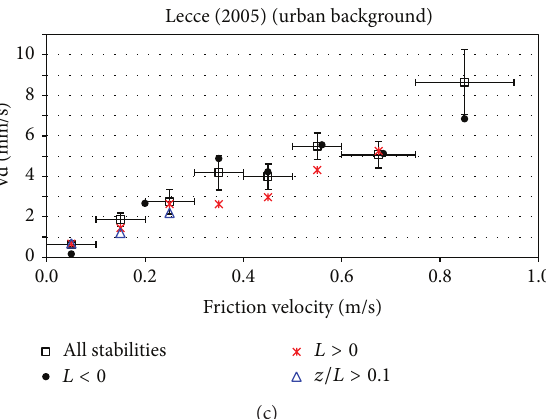
Figure 2: Functional dependence of deposition velocity (Vd) from friction velocity ( 𝑢 ∗ ) for different measurement datasets (as reported in the title of each graph) for PM2.5 mass concentration. Error bars represent standard